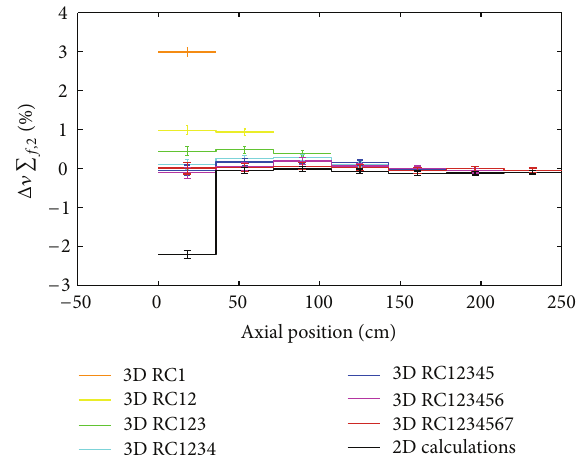
Figure 23: Relative differences between fission neutron production cross sections for the thermal group.